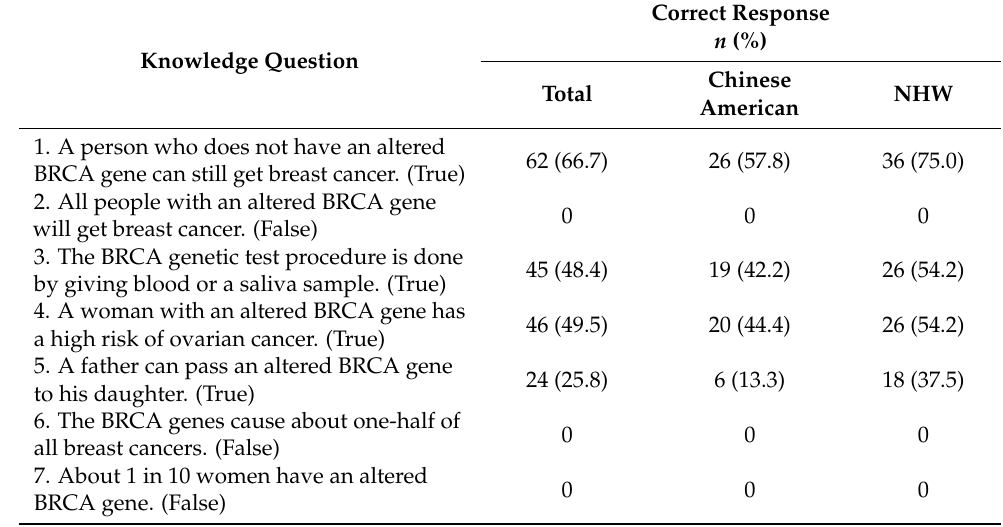
Table 3. Participant BRCA genetic testing knowledge.